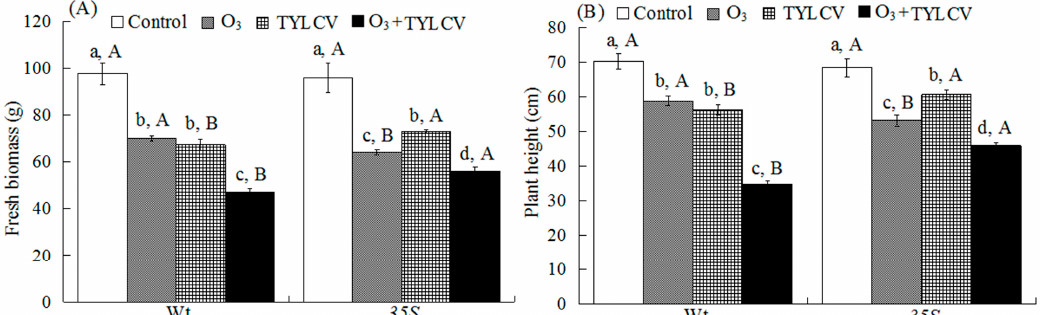
Figure 1. Fresh biomass ( A ); and plant height ( B ) of two tomato genotypes (Wt and 35S ) grown under ambient and elevated O 3 with and without TYLCV infection for six weeks. Control refers to plants grown under ambient O 3 and without TYLCV. O 3 refers to uninfected plants grown under elevated O 3 . TYLCV refers to TYLCV-infected plants grown under ambient O 3 . O 3 + TYLCV refers to TYLCV-infected plants grown under elevated O 3 . Each value represents the average (±SE) of 24 replicates. Different lowercase letters within a row indicate significant differences among the four treatments in a specific tomato cultivar, and different uppercase letters indicate significant differences between the two tomato genotypes within the same treatment (Tukey’s test: p < 0.05).